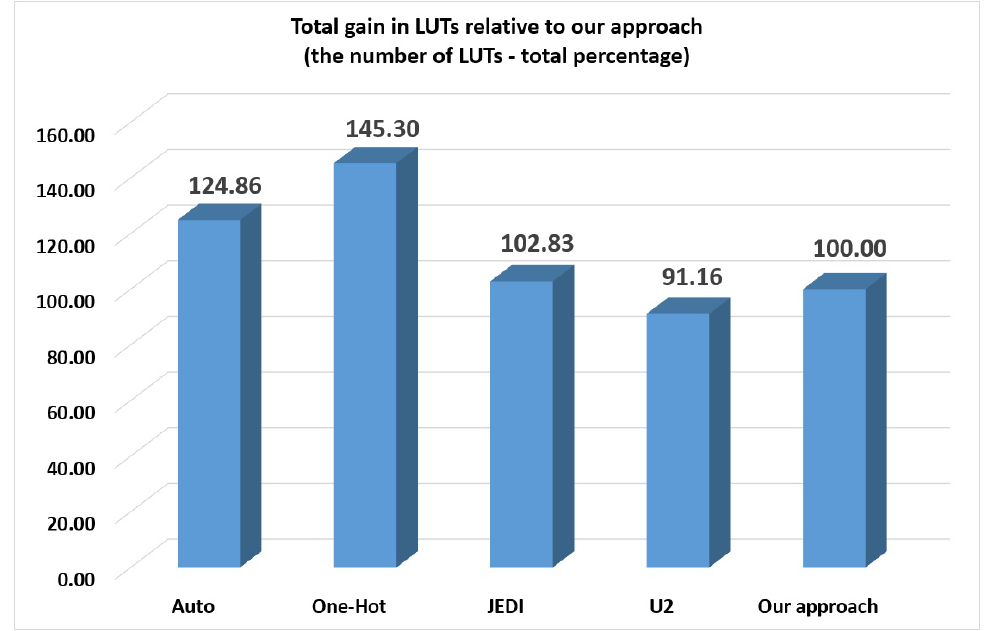
Figure 9. Total gain in LUTs relative to our approach (LUT count—total percentage).